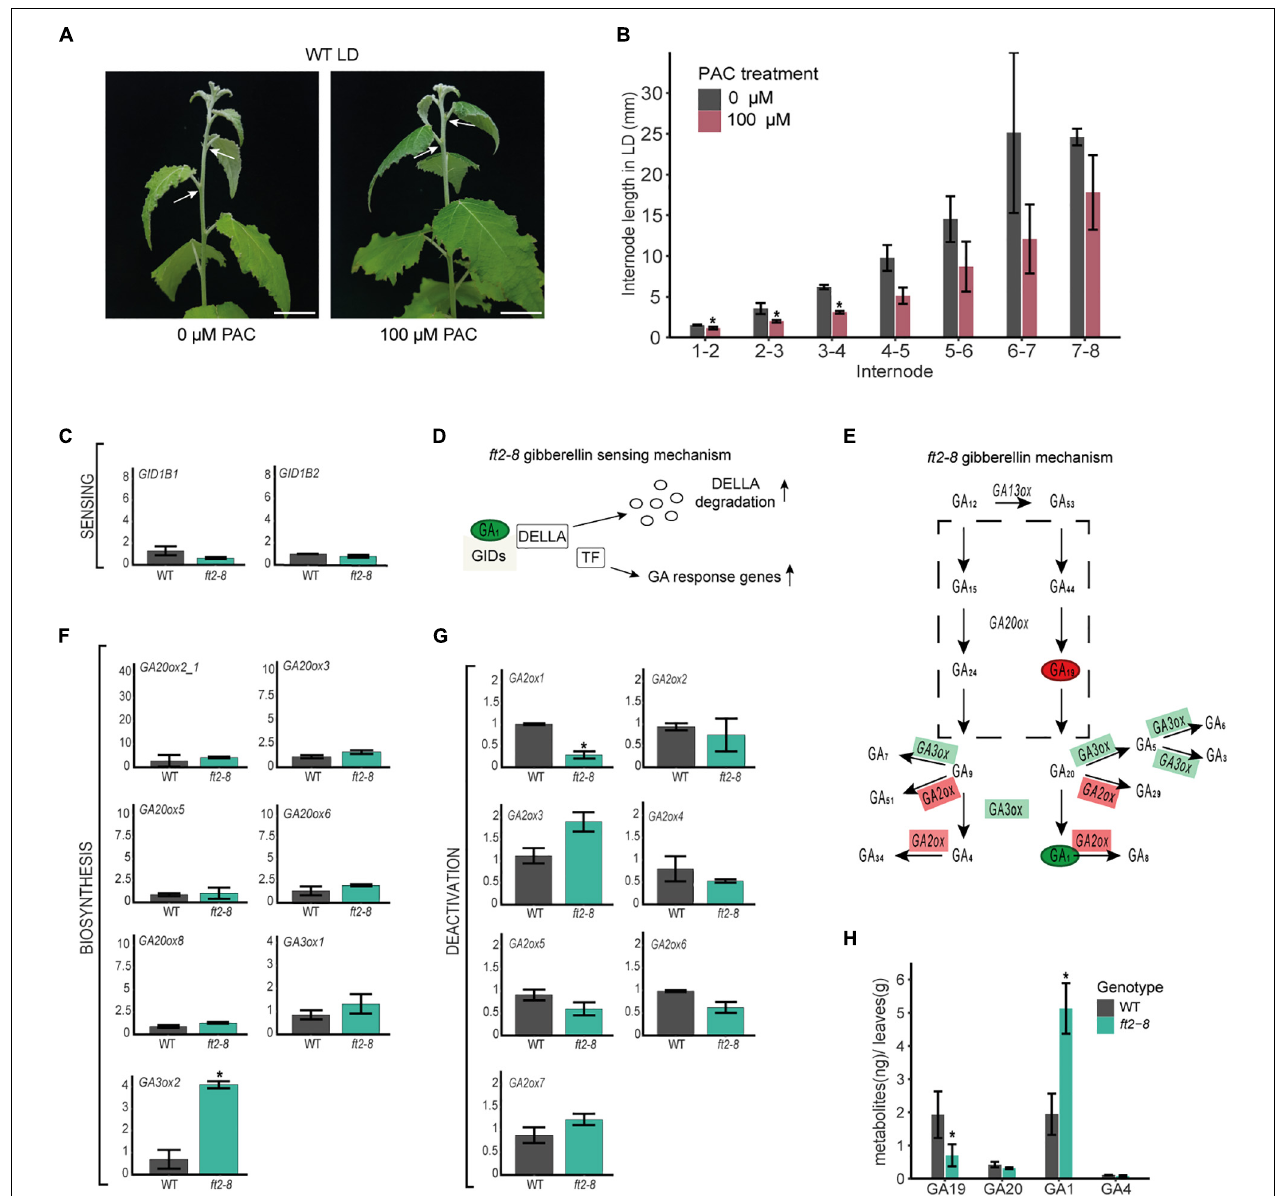
FIGURE 4 | FT2 restricts the GA 13-hydroxylation pathway branch in mature leaf tissue. (A) Images of WT shoot treated with 0 or 100 µ M of PAC for 15 days under LD conditions. White arrows indicate internode 5–6. Scale bar = 2 cm. (B) Bar plot showing internode length (mm) in the stem elongation zone of WT plants treated with 0 µ M and 100 µ M of PAC for 15 days under LD conditions. Plotted values and error bars are fold-change means ± SD recorded in two biological replicates. Asterisks (*) represent significant differences assessed by one-way ANOVA ( p < 0.05) between PAC treatments. (C) Bar plot showing relative mRNA levels of the GA sensing genes GID1B1 and GID1B2 in WT and ft2-8 leaf tissue. Plotted values and error bars are fold-change means ± SD recorded in three biological replicates. Asterisks (*) represent significant differences between PAC treatments assessed by one-way ANOVA ( p < 0.05). (D) Schematic representation of the GA-GIDs-DELLA molecular model (Nelson and Steber, 2018). High GA 1 levels might increase GA responses. (E) Schematic representation of GA metabolism. Green and red rectangles denote genes found upregulated and downregulated in ft-8 compared to WT leaf tissue, respectively. Green and red ovals show precursor and bioactive GA found at higher and lower levels in ft-8 compared to WT leaves, respectively. (F,G) Bar plot showing relative mRNA levels in ft2-8 and WT leaf tissue. (F) The GA biosynthesis genes GA20ox and GA3ox, and (G) GA deactivation genes GA2ox . (H) Bar plot showing the quantification of precursors and bioactive GA in WT and ft2-8 shoot apex. The Y-axis scale represents metabolites (ng)/apex (g), and the X-axis indicates the precursor or bioactive GA measured that is, GA 19 , GA 20 , GA 1 or GA 4 . (C,F,G) Plotted values and error bars are fold-change means ± SD recorded in two biological replicates. Ubiquitin7 was used as the housekeeping gene. Asterisks (*) represent significant differences between genotypes assessed by one-way ANOVA ( p < 0.05).